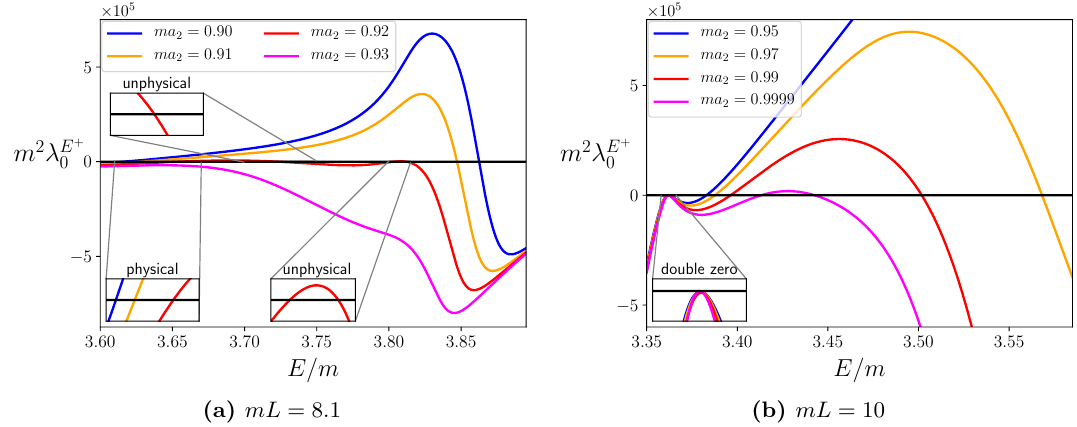
in the E + irrep as a function of the energy for 3 0 : 1 and r 0 = P 0 = = 0. Physical and (cid:0) K df ; 3